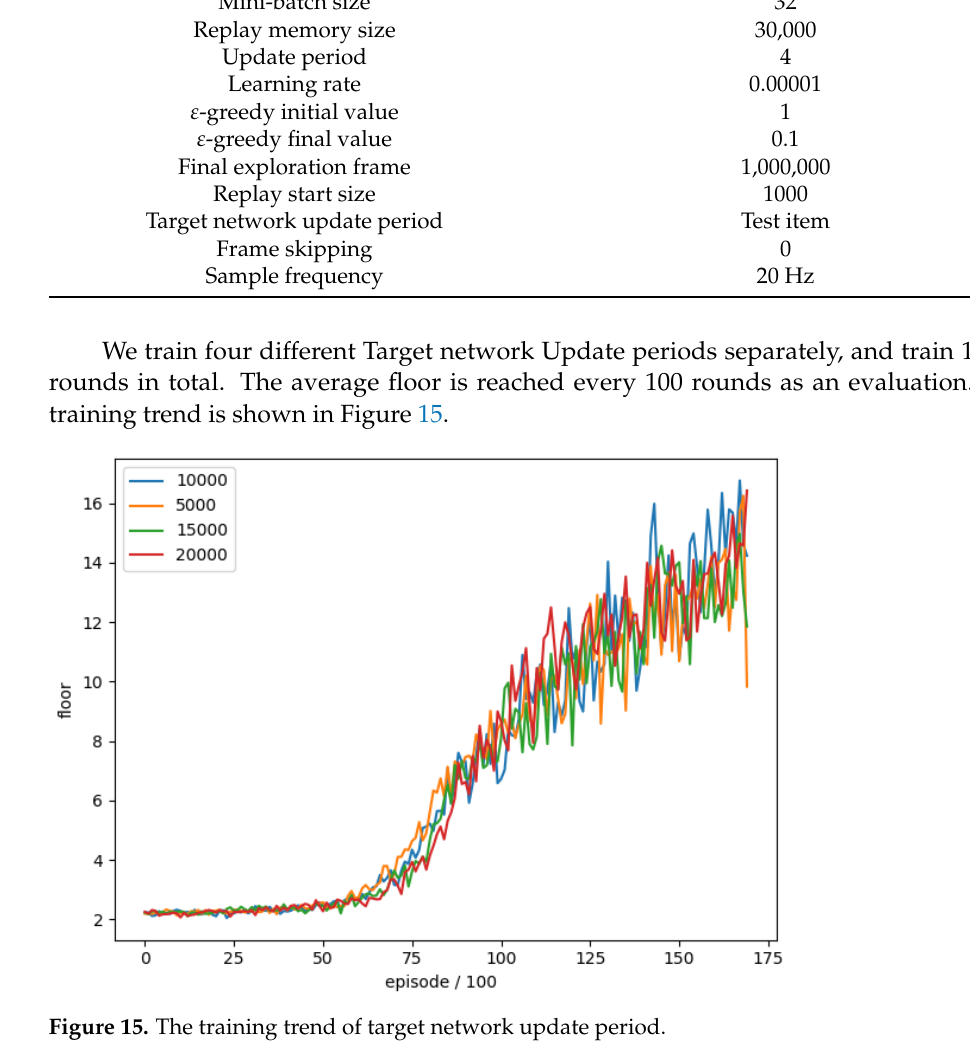
Figure 15. The training trend of target network update period.